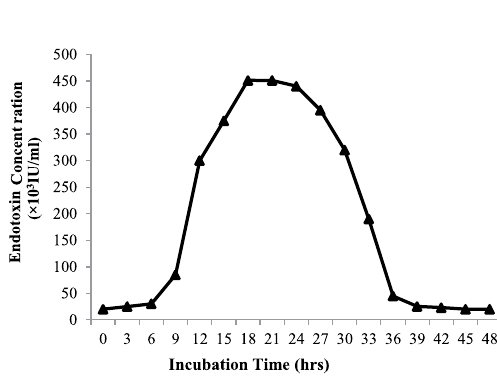
Fig. 3 . Time course of the endotoxin production by P.